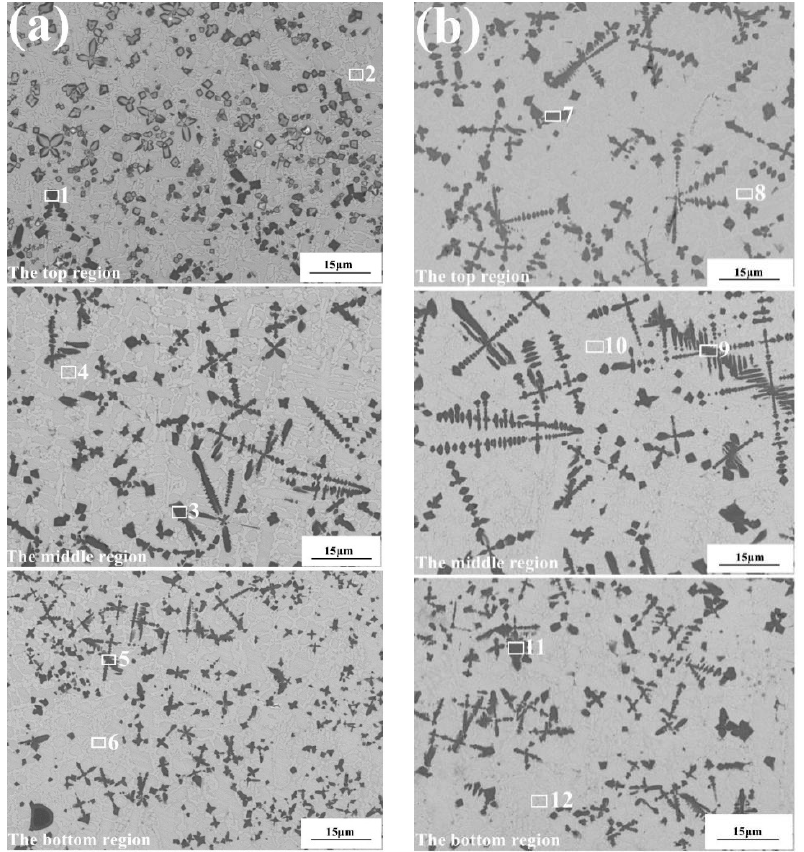
Figure 12. Microstructure of the top, middle, and bottom of the cladding layer at different scanning speeds: ( a ) 6# sample: 1.4 kW, 7 mm/s, 1400 L/h, 20% TiC; ( b ) 8# sample: 1.4 kW, 5 mm/s, 1400 L/h, 20% TiC.